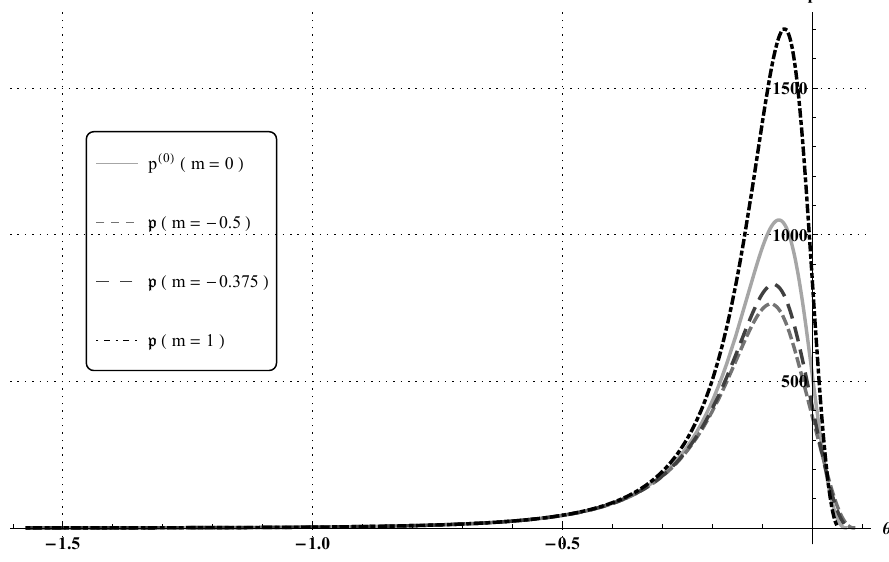
Figure 3. Pressure distributions computed from the classical Reynolds equation, p ( 0 ) ( θ ) ( m = 0 ) , and from the power-law system of Reynolds type equations, p ( θ ) ( m = − 0.5, − 0.375,1 ) , with (cid:101) = 0.01 and α 0 = O ( (cid:101) 3 ) . Table 2. Cavitation angles θ 2 and the normal forces ω (cid:48) p , computed for m = − 0.5, − 0.375,1, when (cid:101) = 0.01. m θ 2 (rad) ω (cid:48)